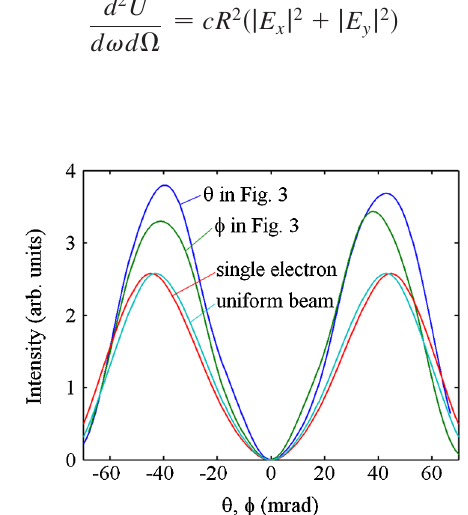
FIG. 5. (a) Transition radiation intensity with 1-THz frequency for different distances from the target and (b) the peak-intensity angles (cid:7) m as a function of the distance from the target for different frequencies. Numbers indicating the curves in (a) are distances R in units of m.